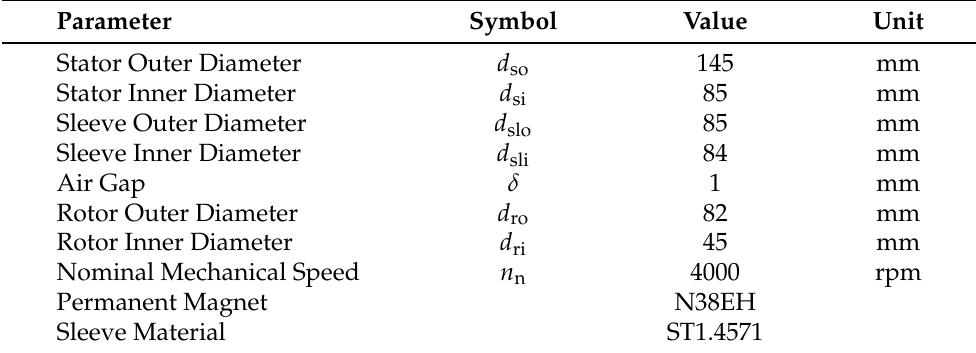
Table 2. Machine